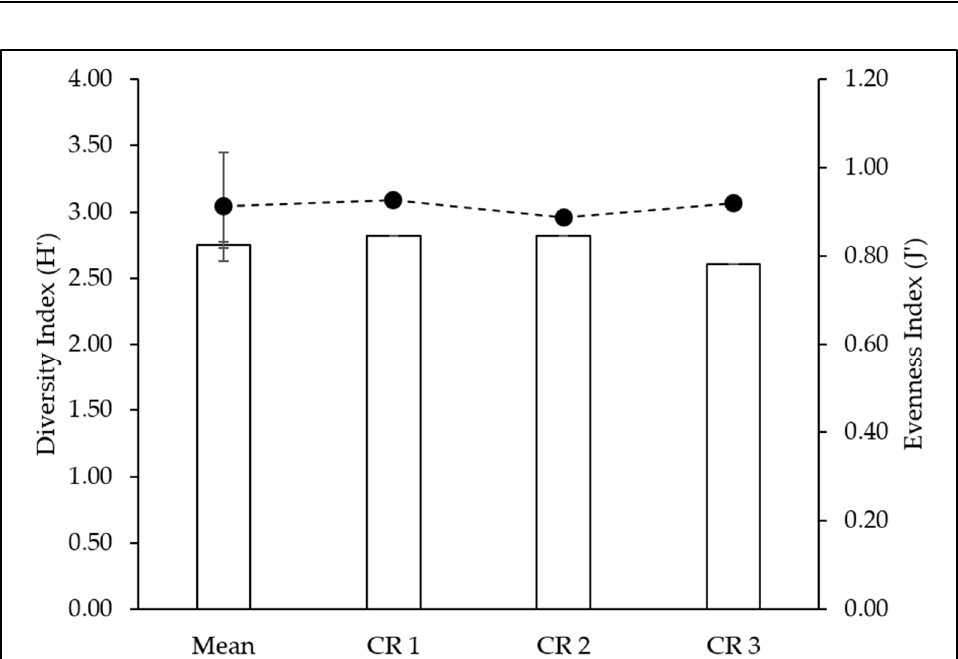
Figure 8. Shannon Diversity, H’ (bar), and Pielou Evenness, J’ (•), Indices of the fish detected in the BK AR. Error bars indicate the standard deviation.